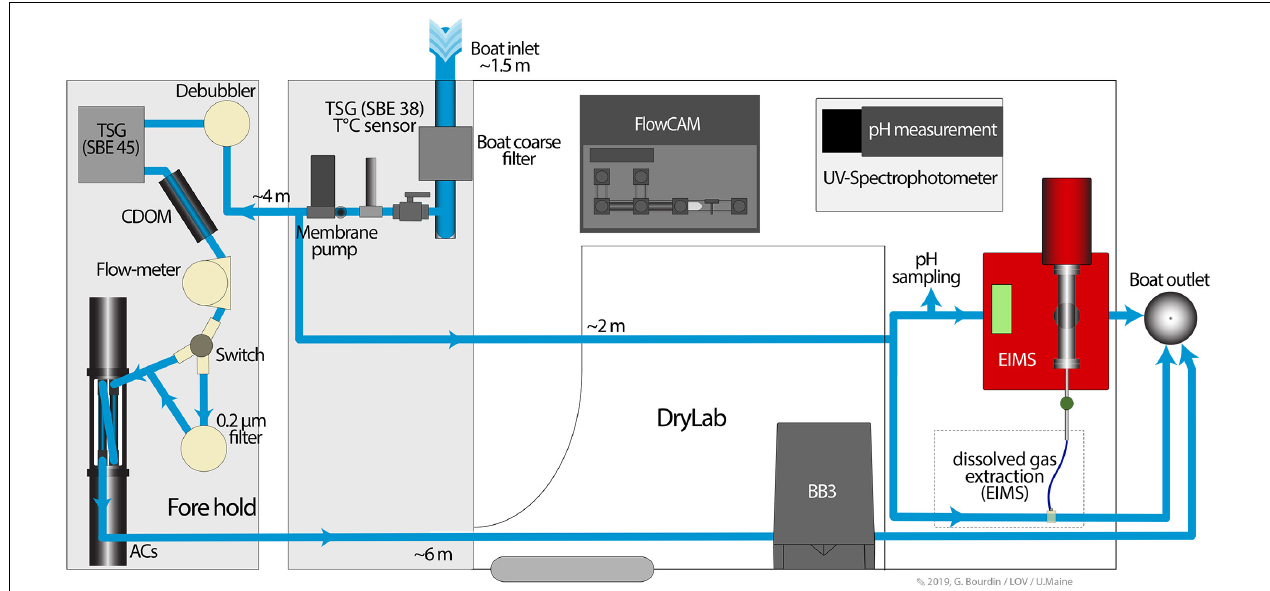
FIGURE 3 | Schematic diagram of the underway, continuous sampling system, showing the setup of the various flow-through instruments and the distance between the water intake and each instrument. The water flow is shown in blue. The FlowCam and the UV-spectrophotometer were installed in the drylab for live imaging of microplankton and pH